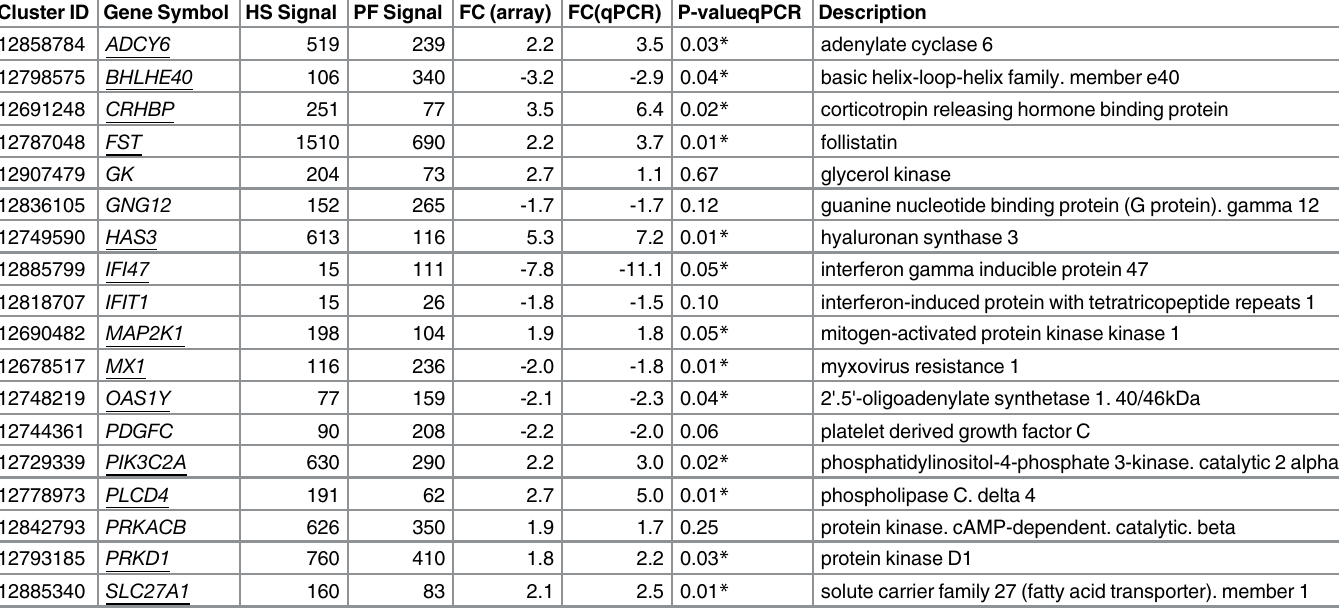
Table 3. qPCR re-evaluation of selected, differentially expressed transcripts according to microarray analysis.